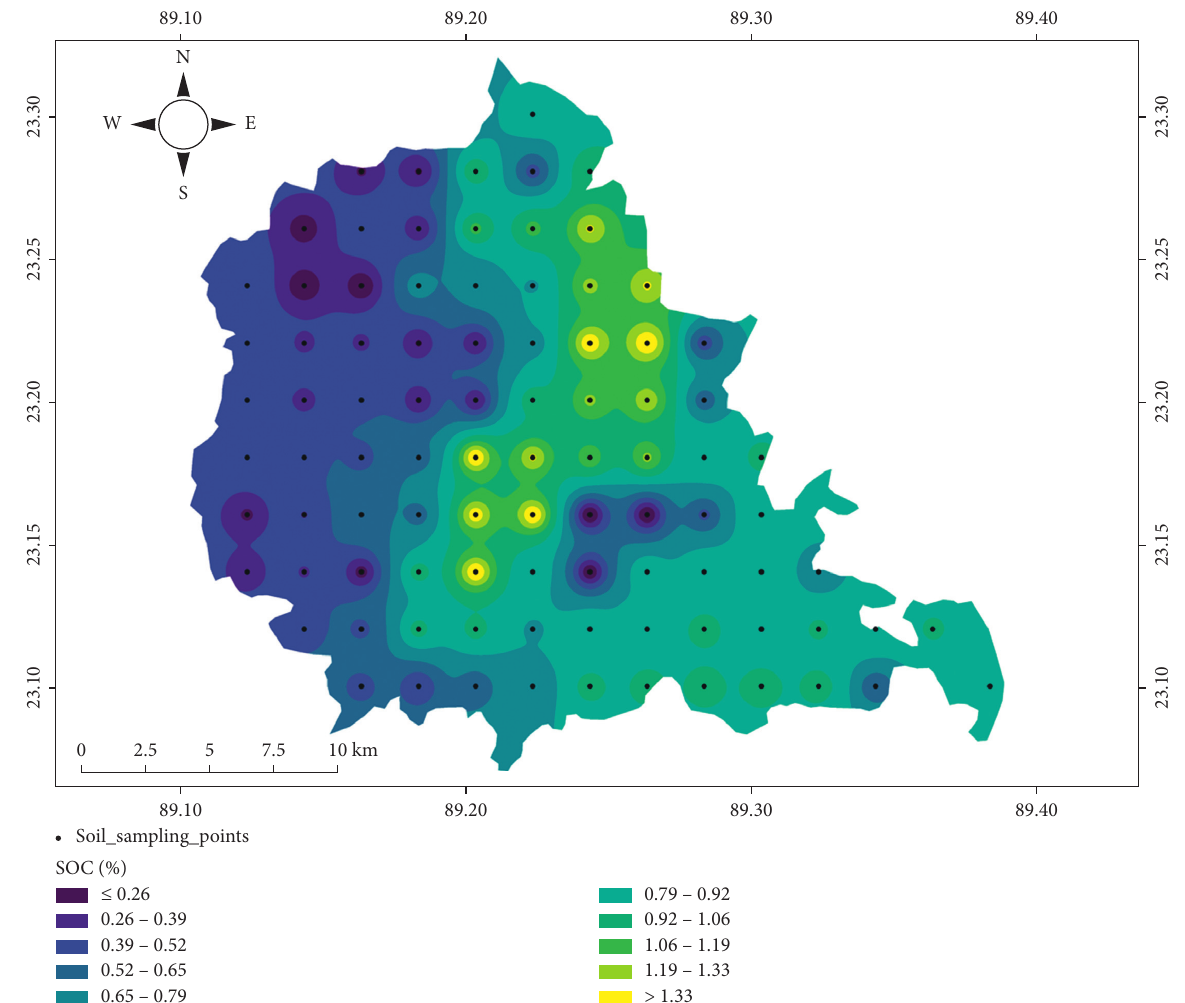
Figure 7: Spatial distribution of soil organic carbon (SOC) contents in the study